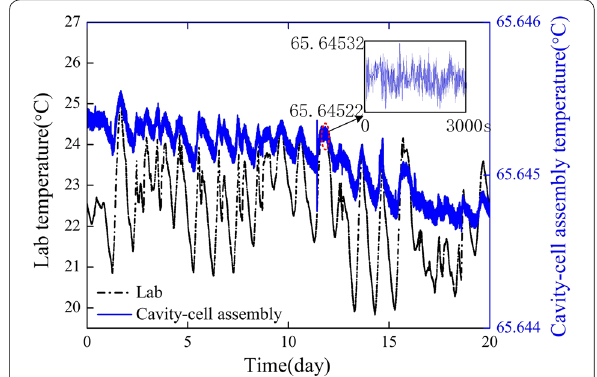
Fig. 6 Recordings of the cavity-cell assembly and laboratory temperature. Inset: short-term fluctuation of the cavity-cell assembly